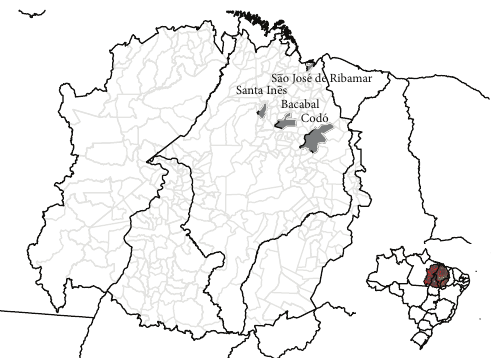
Figure1:MapofMaranh˜aoandfourstudysites(SantaInˆes,S˜aoJos´e de Ribamar, Cod´o, and